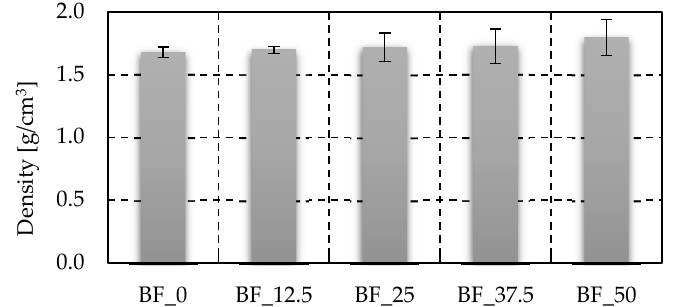
Figure 4. The density of the tested geopolymers.